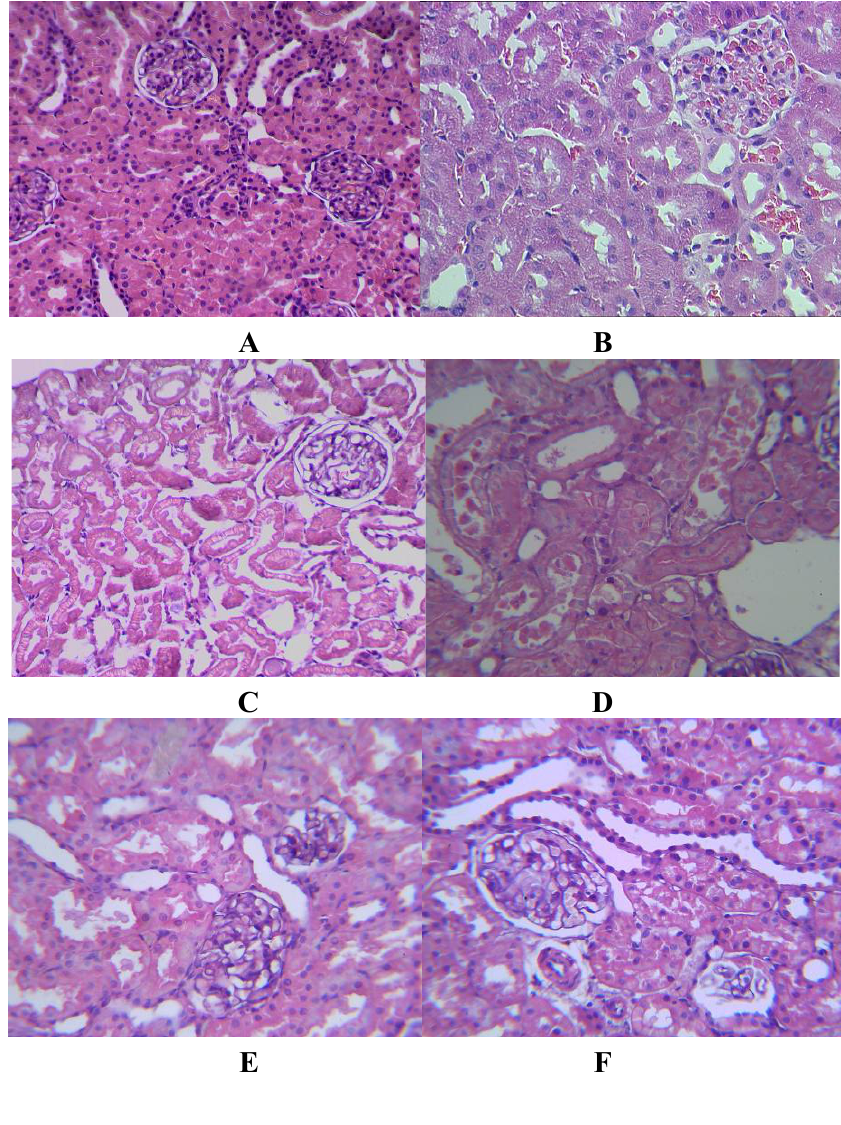
Figure 1. The microscopic evaluation of kidney